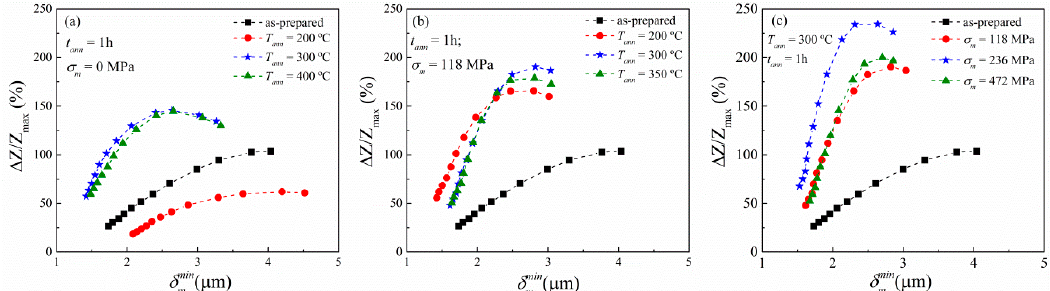
Figure 6. Minimum skin depth dependence of ( ∆ Z/Z ) max for as-prepared and conventional annealed ( a ), as-prepared and stress-annealed at a fixed σ m of 118 MPa while varying the T ann ( b ), and at a fixed annealing temperature while varying the applied stress ( c ) for the Co 69.2 Fe 3.6 Ni 1 B 12.5 Si 11 Mo 1.5 C 1.2 microwires. Dashed-lines are a guide to the eye, while full-symbols denote experimental data. The frequency dependence increases from right to left in contrast to panel ( c ) of Figures 3–5.